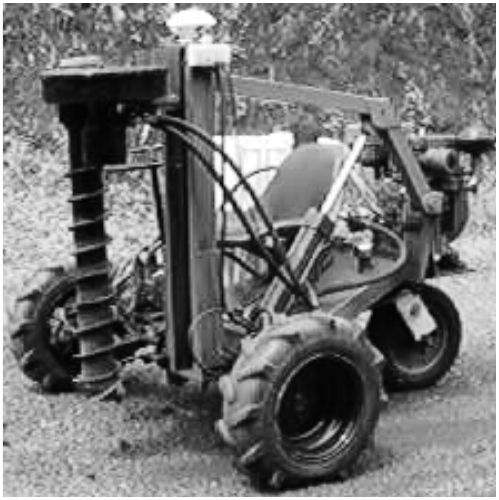
Figura 4. Aspecto final do VAS equipado com antena de